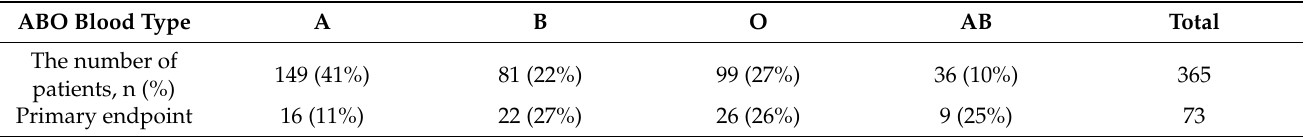
Table 1. The incidence of the primary endpoint and each event in each blood type.